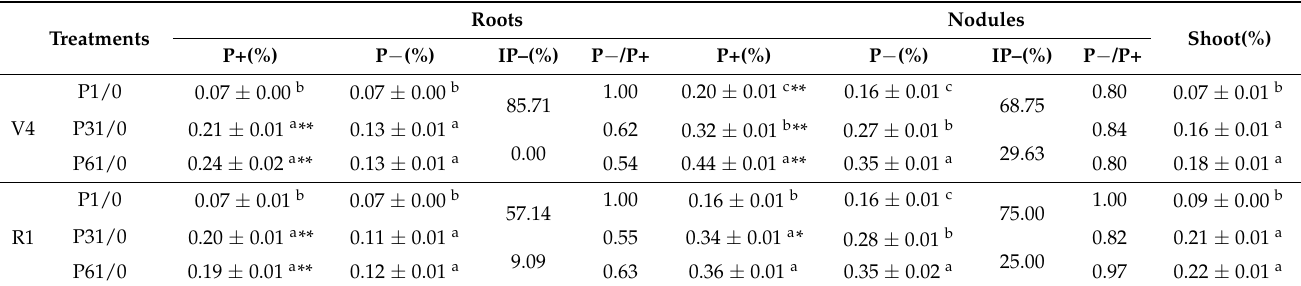
Table 1. Effect of P supply on the P content of dual-root